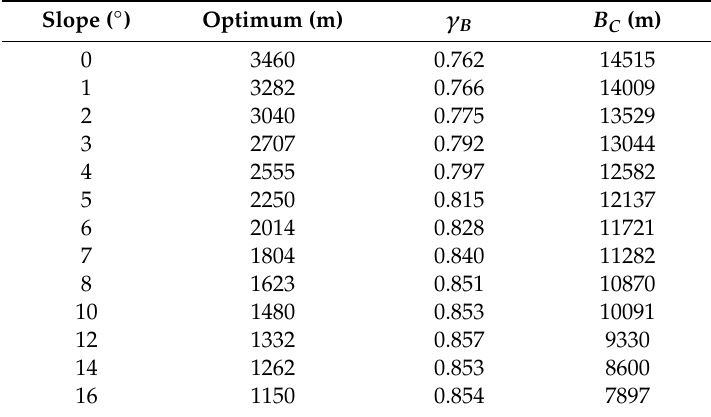
Table 1. Optimal perpendicular baselines for di ff erent terrain